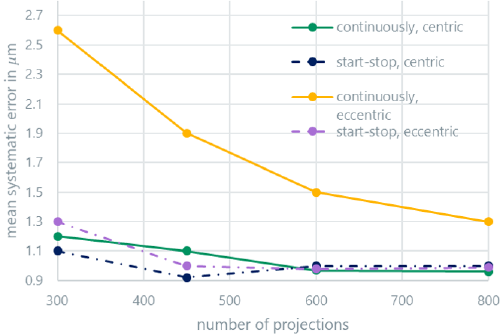
Figure 3. Systematic error in distance measurements.